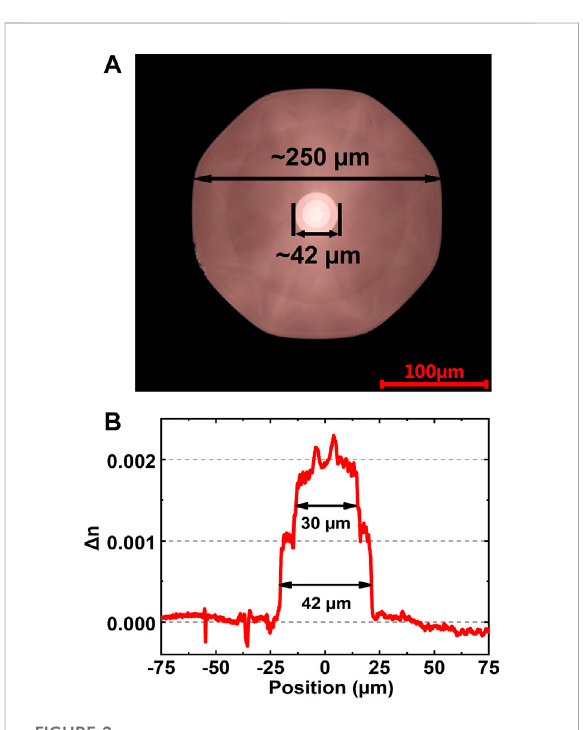
FIGURE 2 Cross-section of the con fi ne-doped fi ber; (B) Measured refractive index pro fi le along the